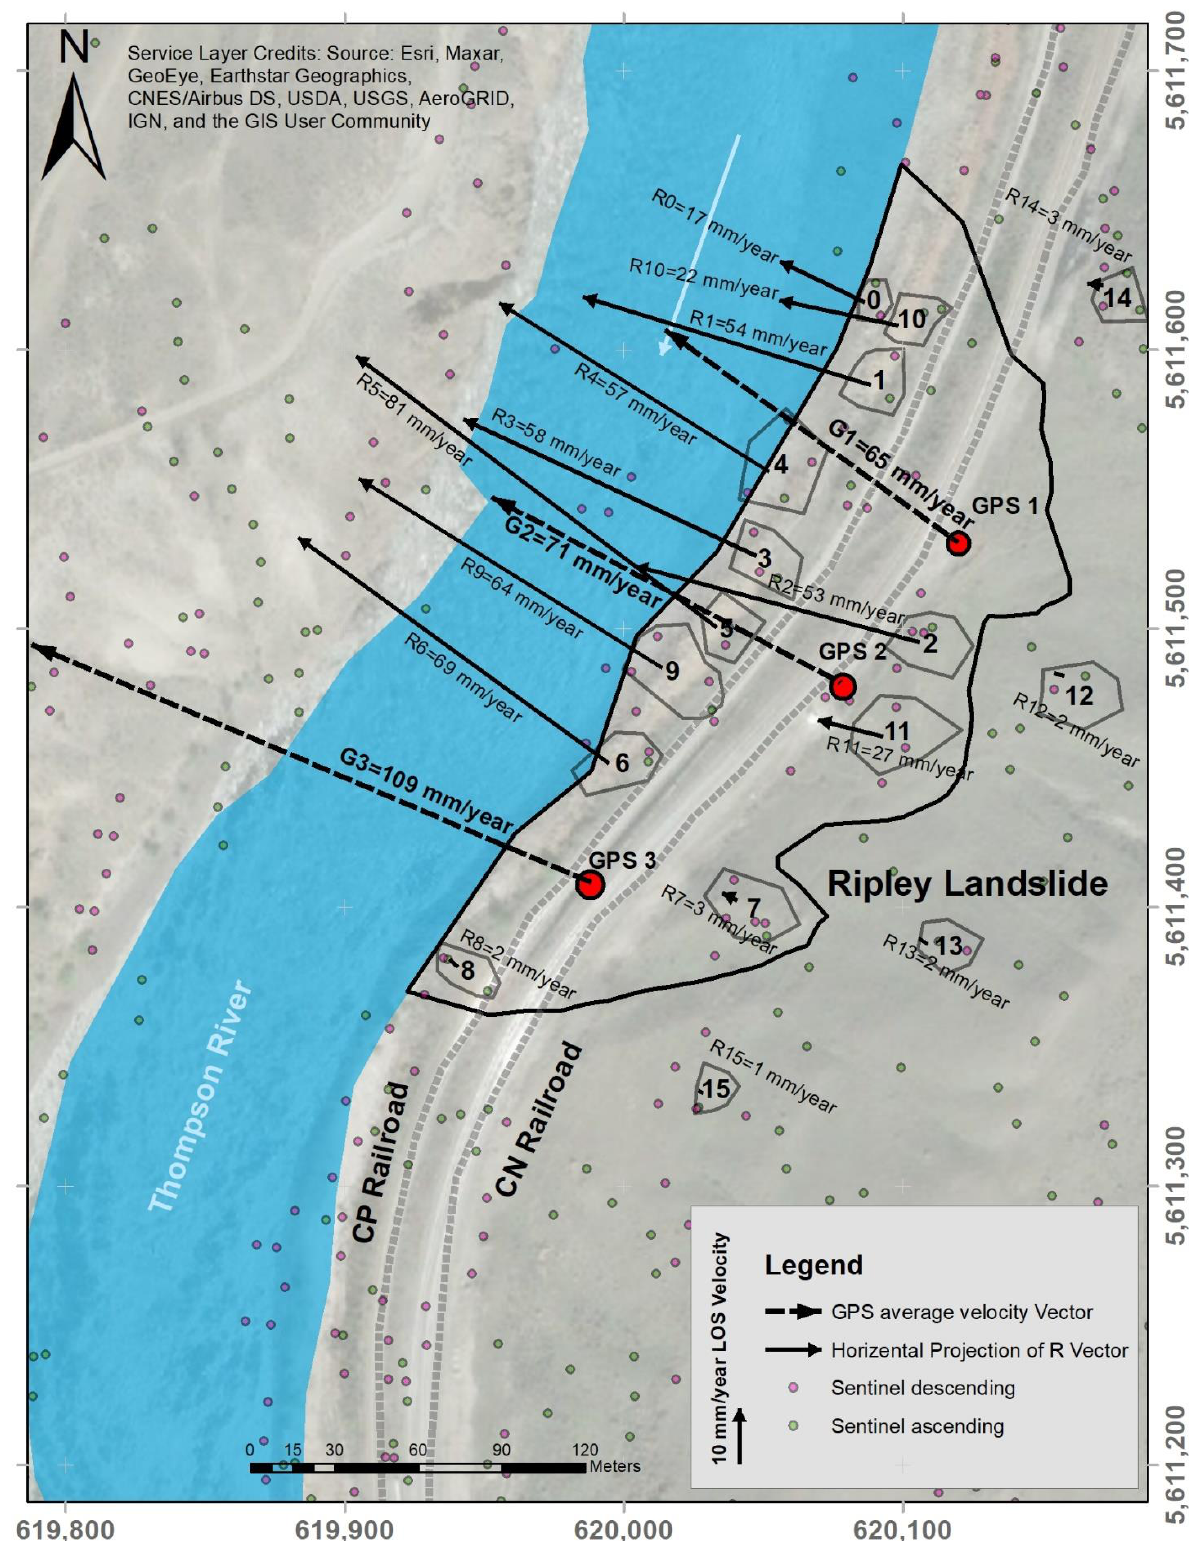
Figure 11. R vectors and GPS average velocity vectors (mm/y) in plan-view.